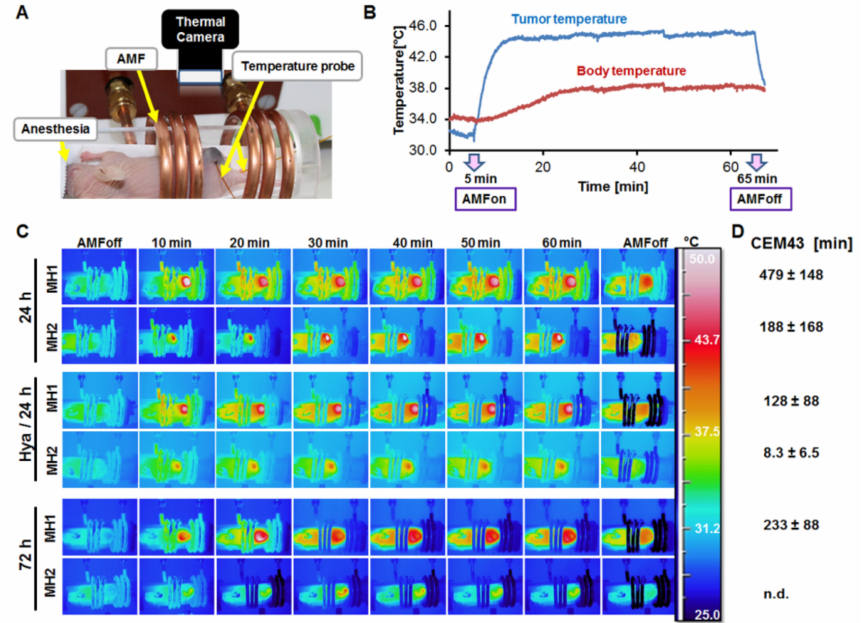
Figure 4. Influence of hyaluronidase on magnetic hyperthermia treatment of pancreatic cancer models in mice. All mice received comparable concentrations (0.5 mg Fe/100 mm 3 tumor volume) of intratumoral Dex-MNP. ( A ) Setup of mice in the alternating magnetic field (AMF). ( B ) Representative temperature curve of tumor and mouse body showing increase and maintenance of heat above 43 ◦ C in the tumor when the AMF is on and the decrease when the AMF is switched off. ( C ) Representative thermographic images of mice treated with the first magnetic hyperthermia (MH1) and the second hyperthermia (MH2) 7 days after. ( D ) Mean and standard deviations of the calculated heat doses (CEM43) per treatment group (n ≥